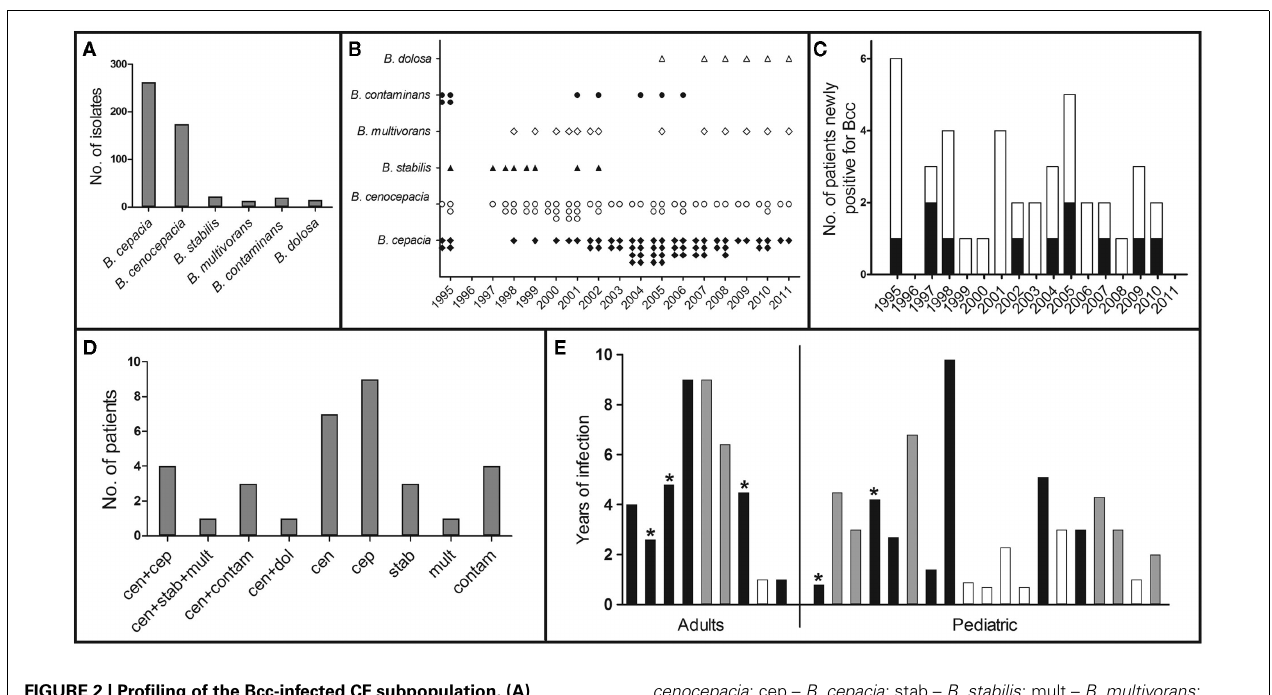
FIGURE 2 | Profiling of the Bcc-infected CF subpopulation. (A) Distribution of the Bcc clinical isolates into the corresponding Bcc species; (B) Chronological distribution of the different Bcc species isolates; (C) Number of patients and date of first Bcc positive isolation (pediatric – white bars and adults – black bars); (D) Number of patients infected with the different species, including co-infection (cen – B.